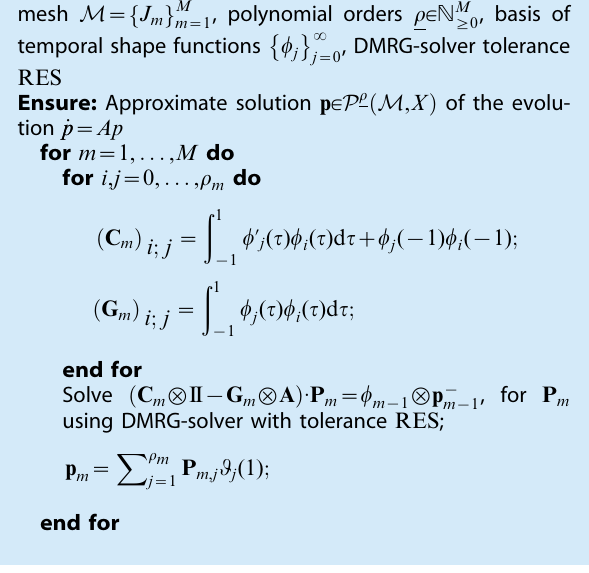
Algorithm 2. hp -DG-QTT CME Solver. Require: Projected CME operator A in QTT format,